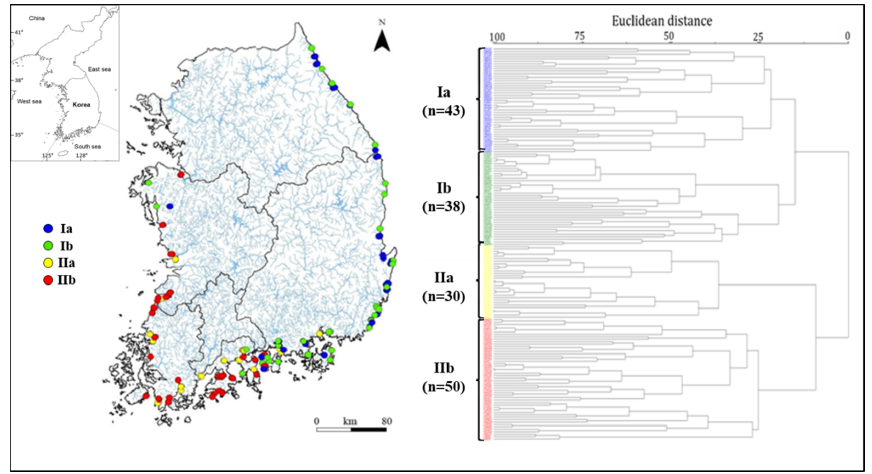
Figure 1. Map of 161 sampling sites for studies of water quality and epilithic diatoms in 90 Korean estuaries from 2012 to 2014; a: Dendrogram of site affinity based on diatom abundance, b: Colors in figures represent the same groups: Ia (blue), Ib (green), IIa (yellow), and IIb (red).